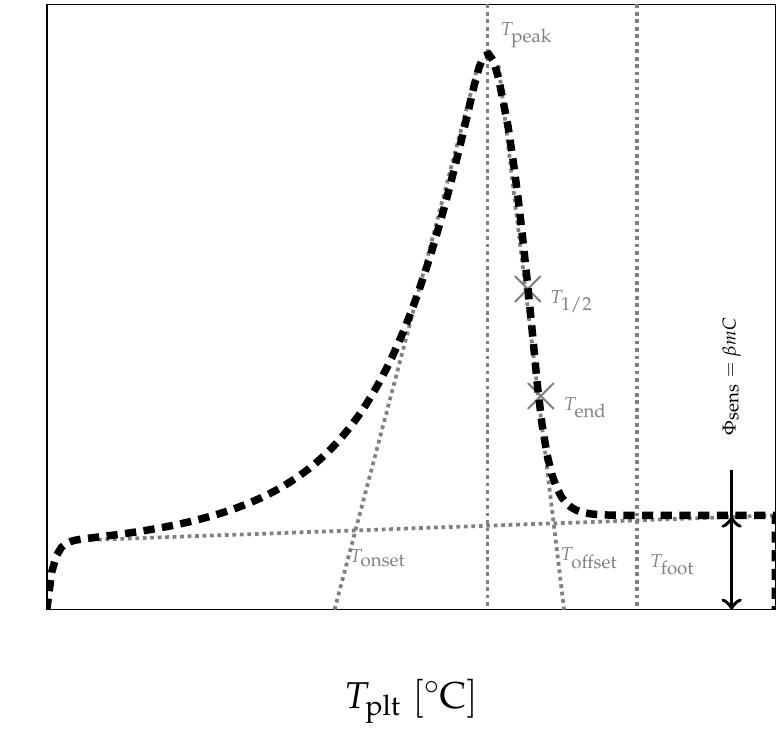
Figure 4. Example of a thermogram with the corresponding characteristic